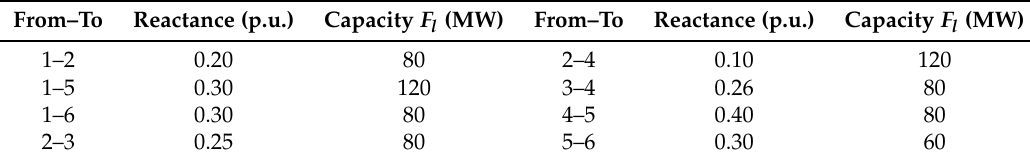
Table 3. Branch data for the 6-bus system.